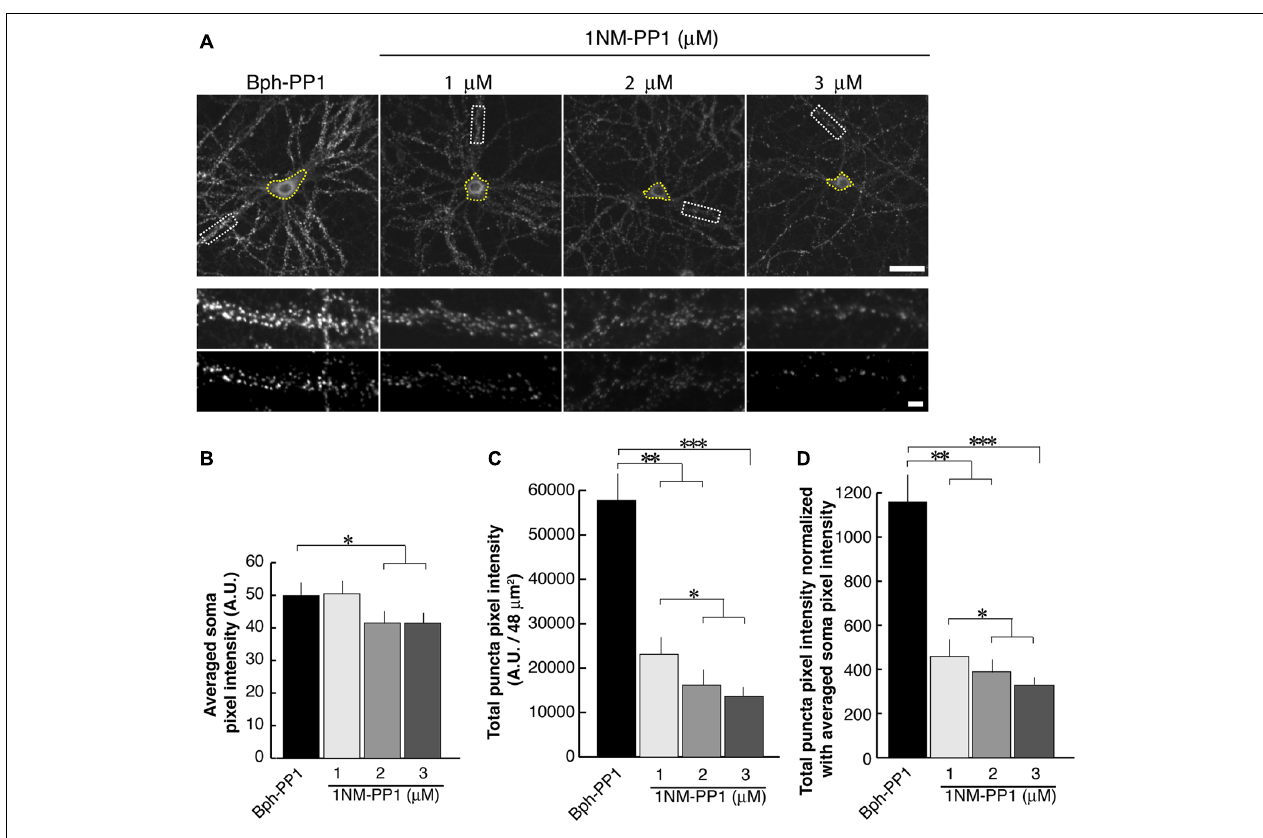
FIGURE 2 | 1NM-PP1 suppresses punctate distribution of PSD-95 dose-dependently in TrkB F616A neurons. (A) The top row shows representative neurons immunostainted with anti-PSD-95. Typical secondary dendritic branches analyzed are shown in 48 μ m 2 rectangles in the middle row. These branches are processed after the thresholding shown in the bottom row. The scales in the top and bottom rows show 10 and 1 μ m, respectively. (B) Graph showing averaged PSD-95